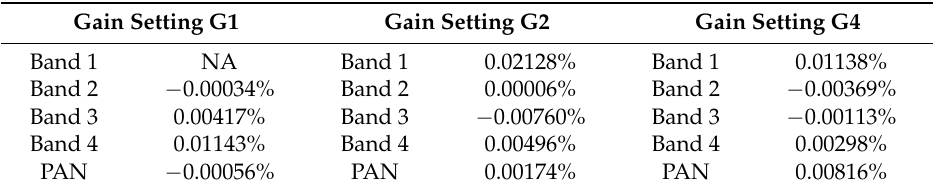
Table 8. Same as Table 7, but the calibration in temporal variation included. The mean error for all gain settings and bands is